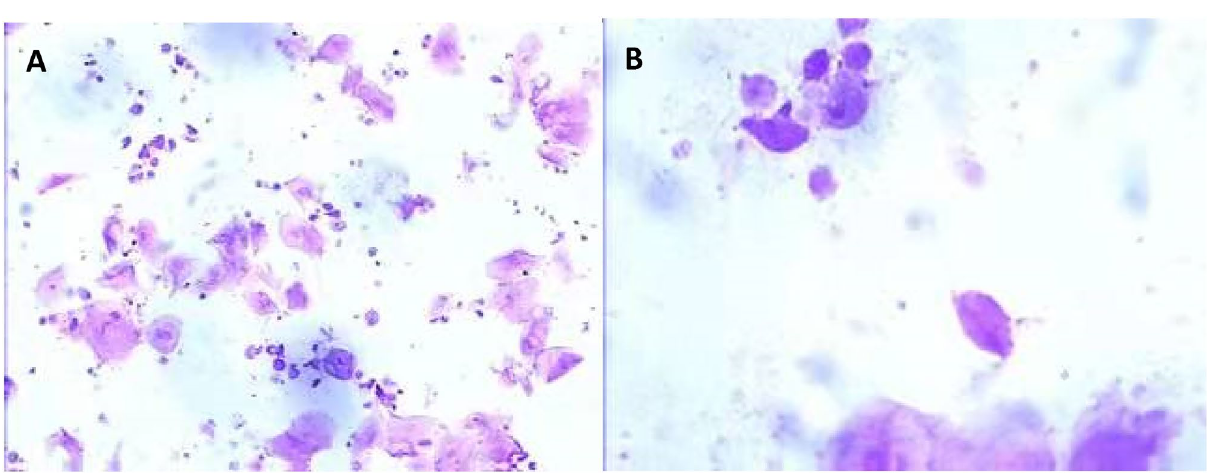
Figure 6. Trichomonas vaginalis shown under a 100 × microscope and 400 ×